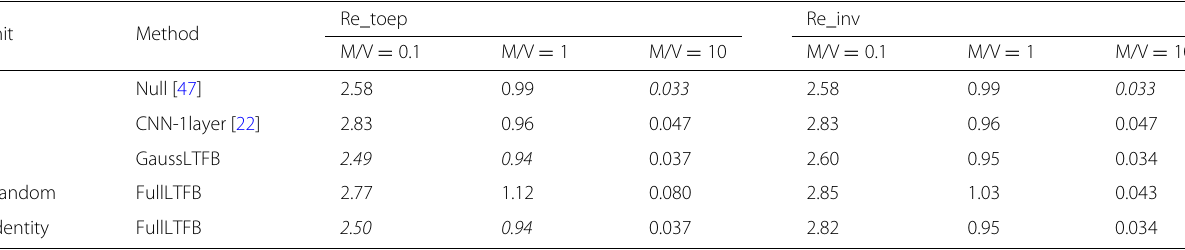
Table 2 Reconstruction error of audio source separation using magnitude spectrograms as input Init